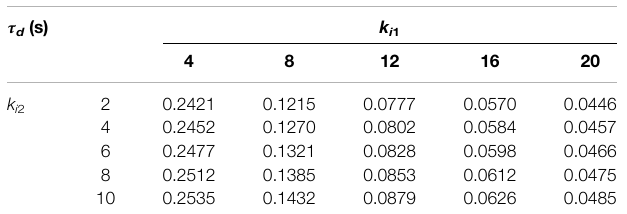
TABLE 2 | Theoretical delay margin of the DC